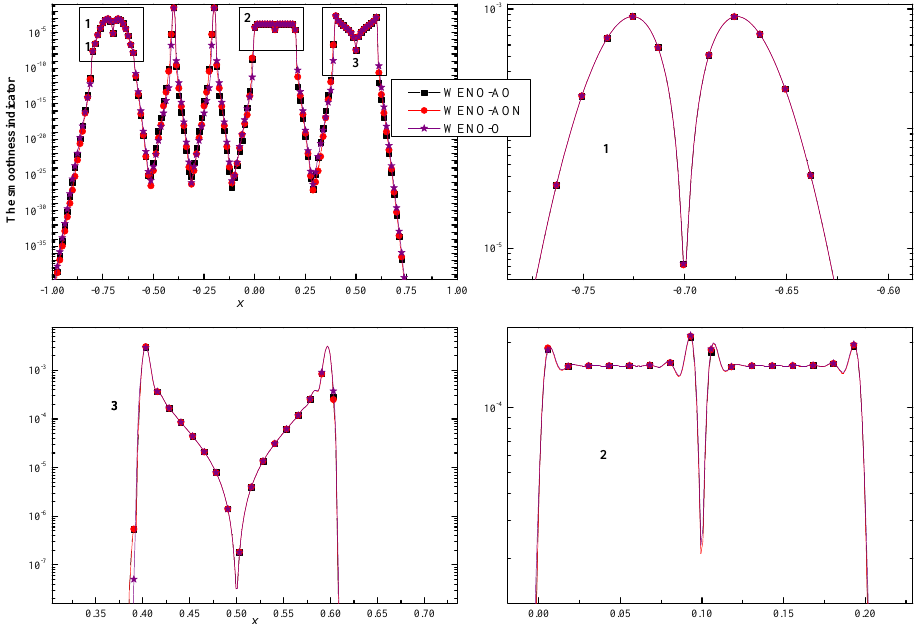
Figure 9. Zoomed regions of numerical solutions of Example 3 (Figure 8) (Section 6.1.3) on 1600 cells at t = 10 and CFL = 0.1.